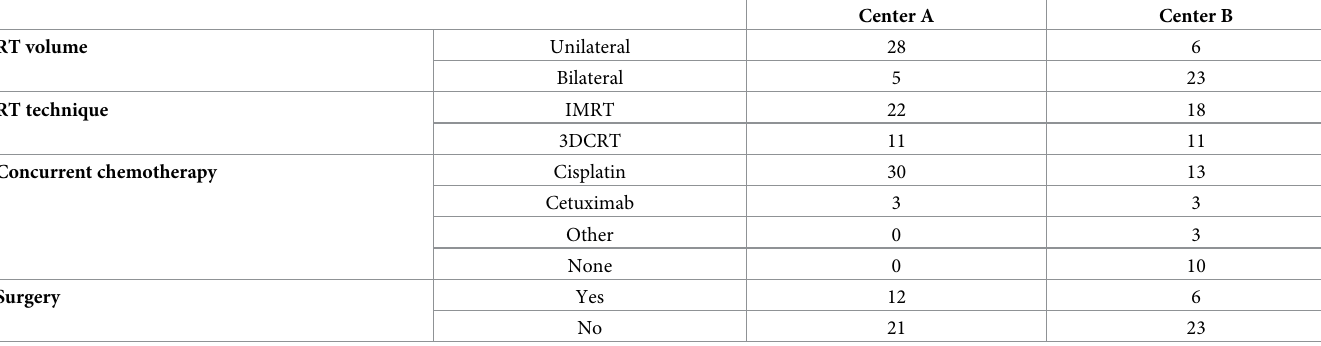
Table 1. Treatment volumes, modalities, and concurrent